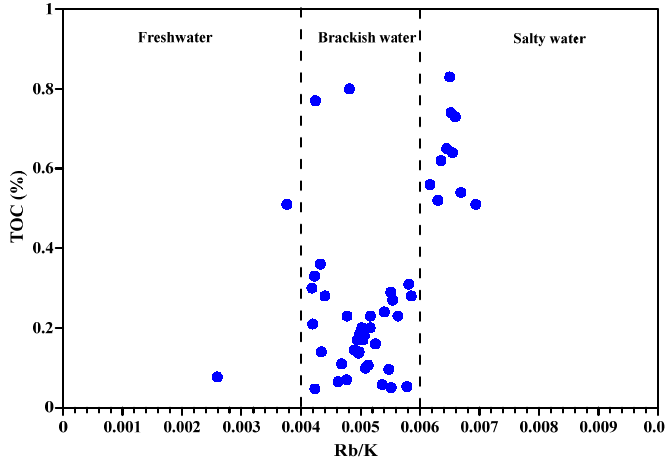
Figure 4. Paleosalinity discrimination of the mudstones in the Meitan Formation. TOC = Total organic carbon.